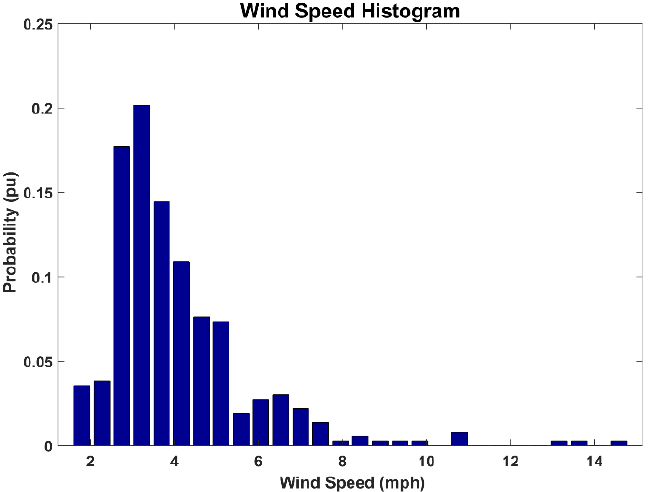
Figure 4. Wind speed histogram of 20-bin. Most variations occur in the 1 – 5 mph wind speed range [35].